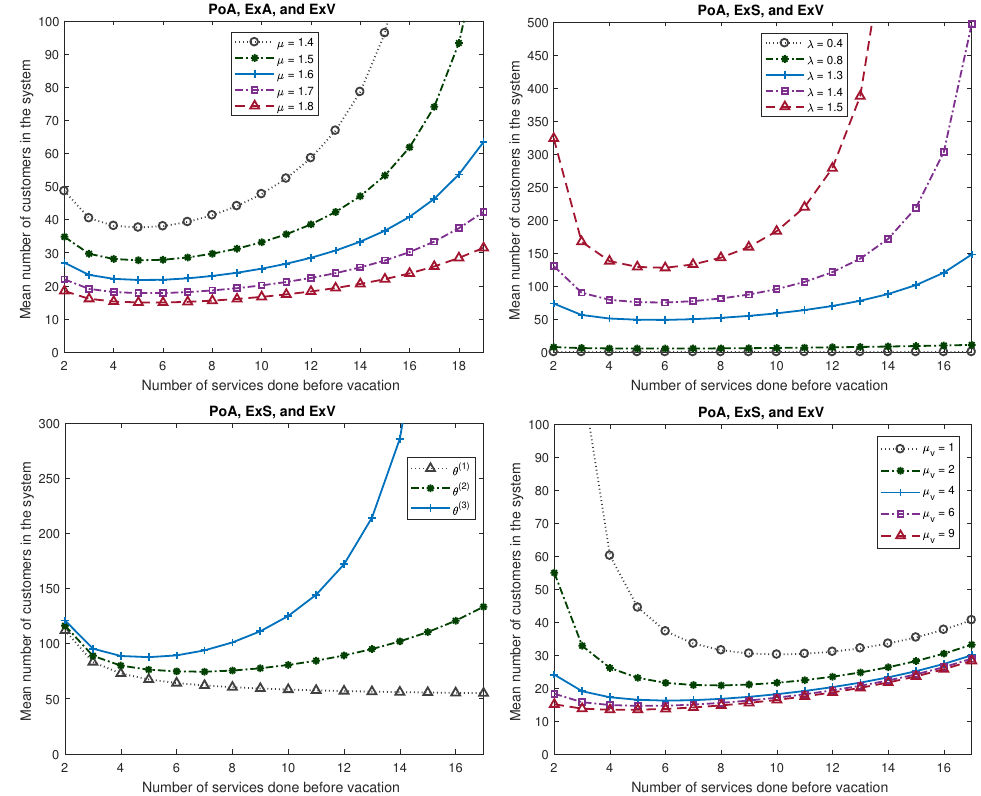
Figure 6. Mean number of customer in the system (Model 2).